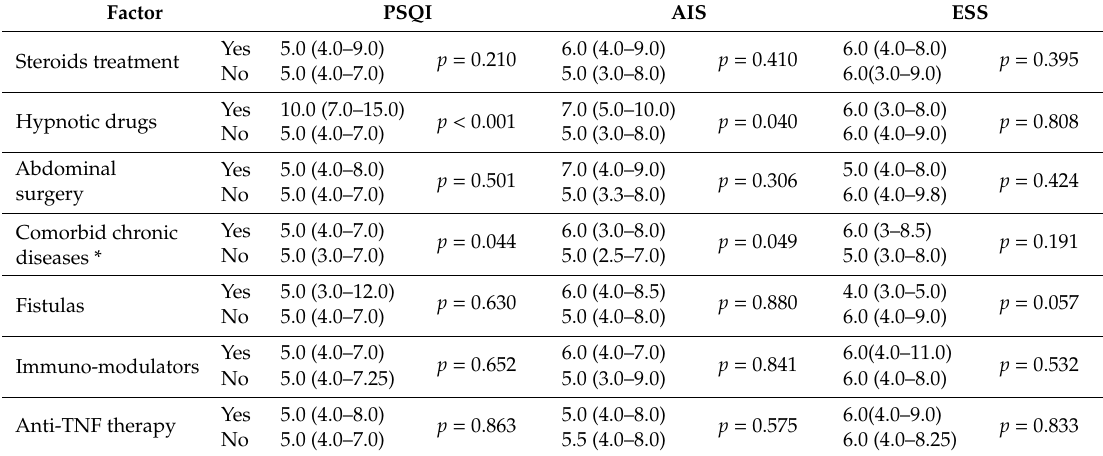
Table 3. Factors a ff ecting the quality of sleep.